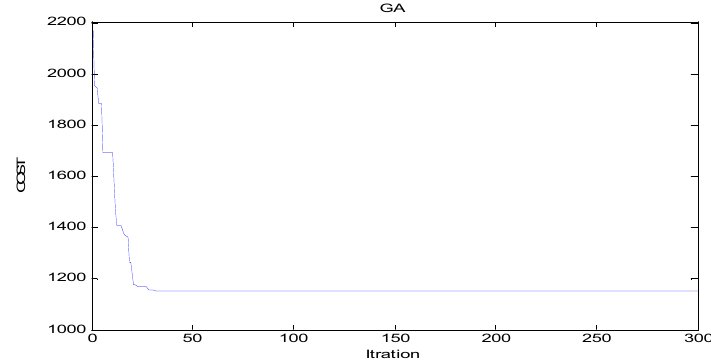
Figure 3. The plot for cost on supply manufacturing system in MATLAB.